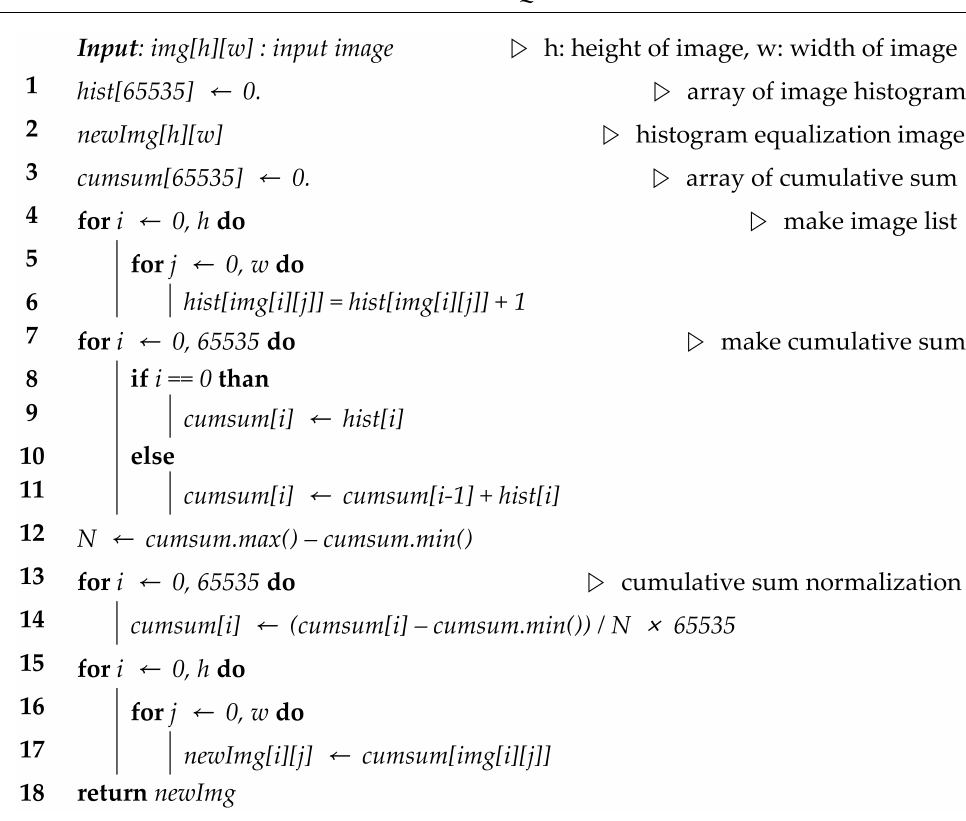
Figure 7. Comparison of the original image and the histogram equalized image: ( a ) original depth image ( left ), and its histogram ( right ); ( b ) histogram equalized depth image ( left ) and its histogram ( right ). ALGORITHM 1: 16BIT IMAGE HISTOGRAM